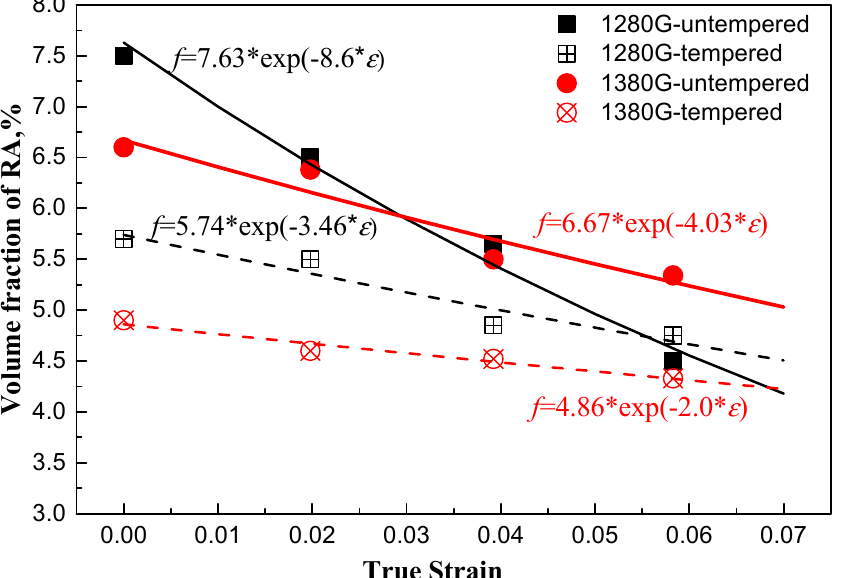
Figure 6. Change of retained austenite amount with engineering strain for 1280G and 1380G rail steels. Note: the errors of all the results obtained by XRD are within ± 5%.